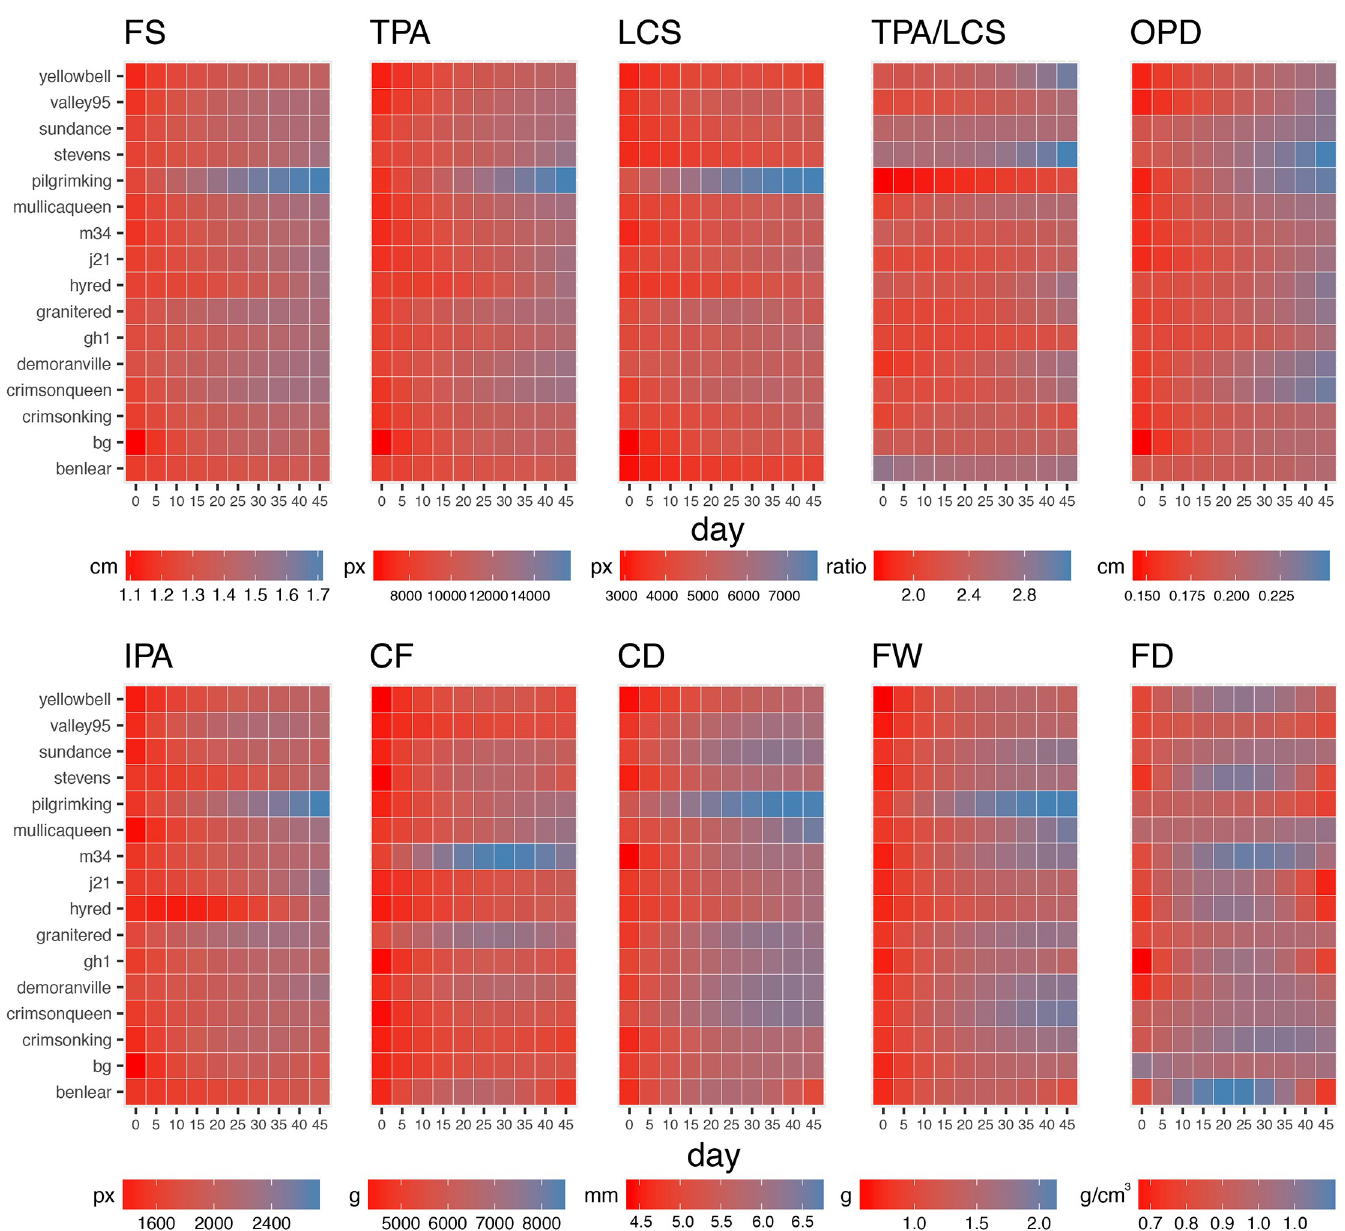
Fig 3. Changes in fruit structure and firmness attributes during the ripening process at cultivar level. Heatmaps for fruit size (FS), total pericarp area (TPA), locule size (LCS), total pericarp area-to-locule size (TPA/LCS), outer pericarp diameter (OPD), internal pericarp area (IPA), compression force (CF), compression distance (CD), fruit weight (FW), and fruit density (FD) are colored according with fitted values obtained from a quadratic model evaluated every 7 days during 10 time points.